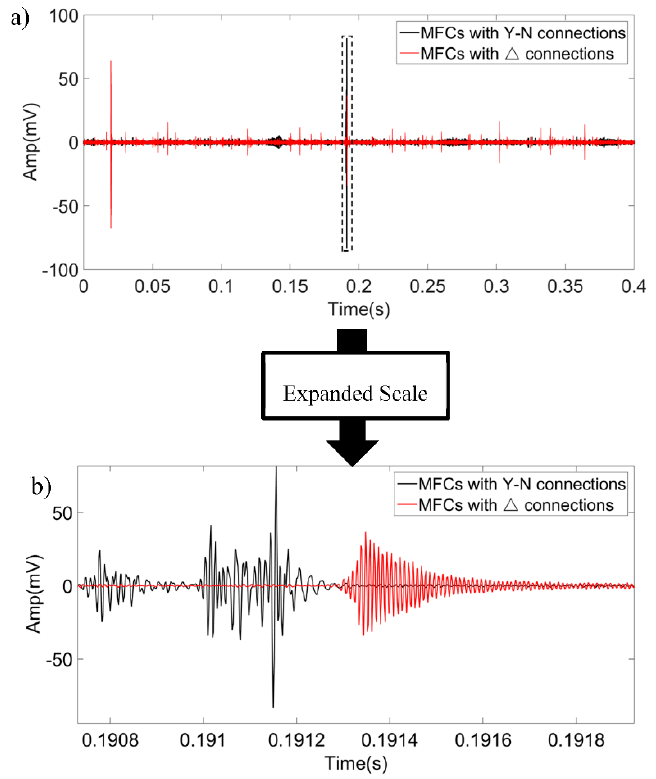
Figure 11. Waveforms of partial discharges in MFCs with different connections: ( a ) total shape, ( b ) shape of a single discharge.